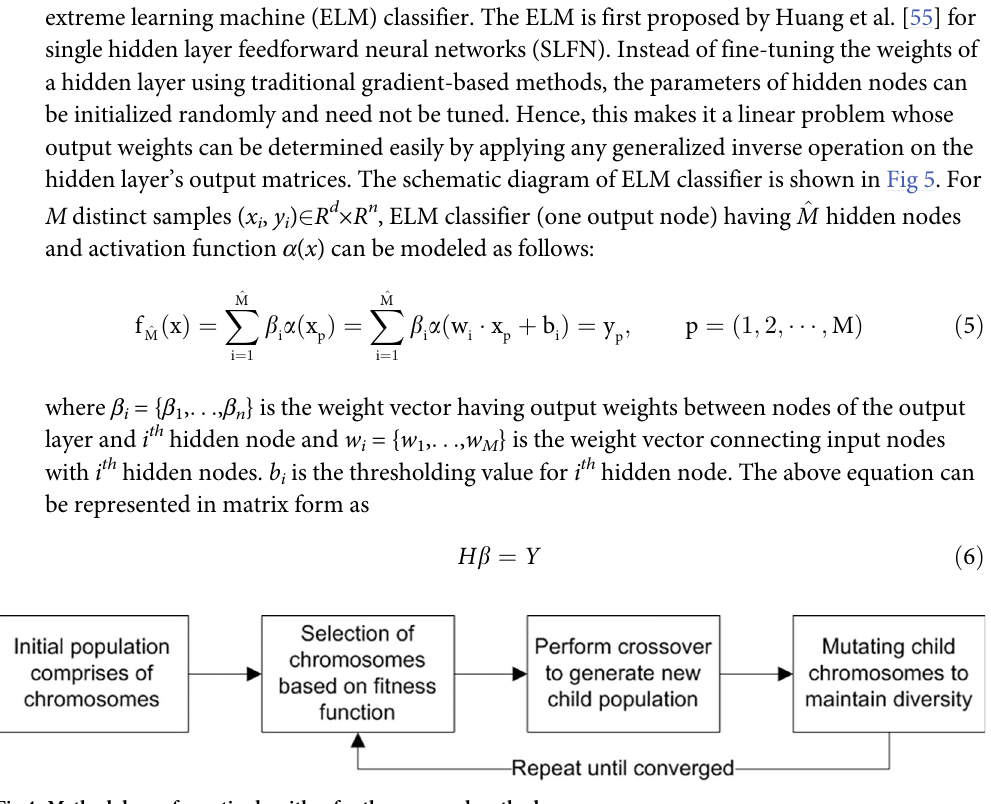
Fig 4. Methodology of genetic algorithm for the proposed